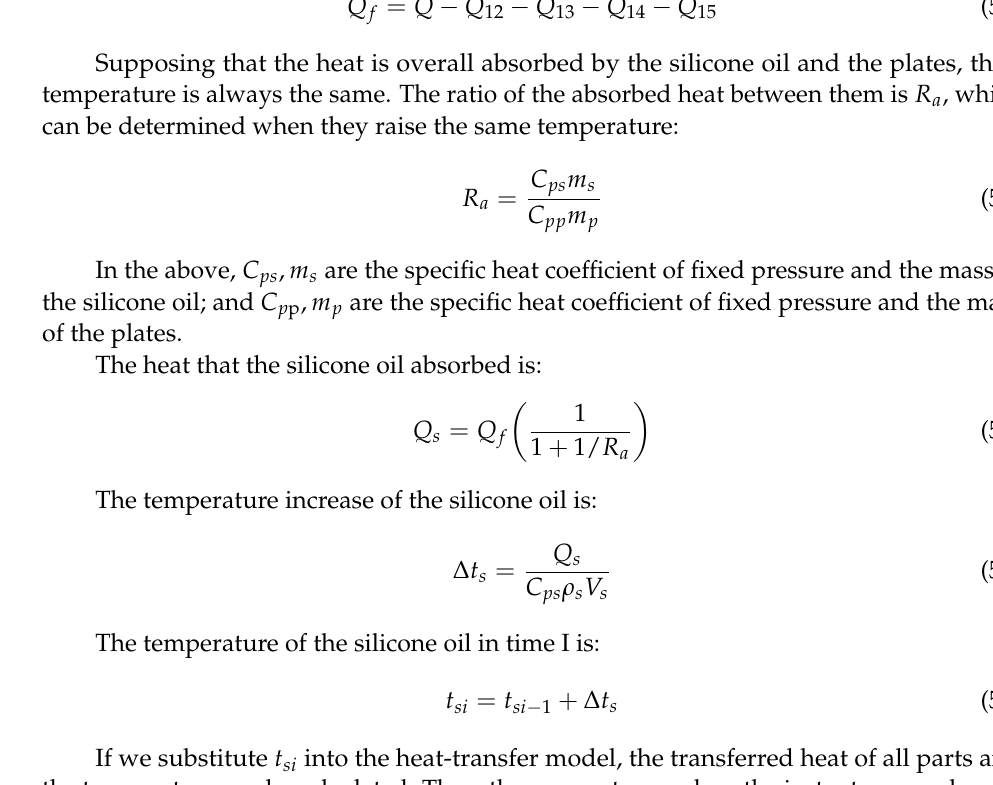
Figure 5. The limited slip torque of the VC. 4. Theoretical Analysis and Calculation of the Hump Mode of the VC When the VC operates at a large speed difference for a long time, the dissipation of the generated heat is insufficient. The excess heat will increase the temperature, inflate the volume, and increase the pressure, and the delivered torque will increase sharply. This is the hump phenomenon. There are several explanations for formation mechanism of the hump phenomenon in reference [7]. No final conclusion has been reached on it so far, but the theory in reference [14] is well accepted. When the hump phenomenon occurs, the internal pressure is very high and difficult to measure. This necessitates the theoretical evaluation. Based on the generation mecha- nism of the hump phenomenon, the following assumptions are made to evaluate the in- ternal pressure: (a) The solubility of silicone oil to air is very low. The proportion of air is considered to be quite small (ignorable) inside the silicone oil; (b) When the hump phenomenon occurs, the gas inside the VC is considered to be an ideal gas, and thus follows the physical law of ideal gases; (c) During the hump phenomenon, the pressure of gas inside the VC is the same as that of the other parts. Based on the above assumptions, the combined gas law is applied to calculate the internal air pressure, which will be used as the pressure inside the shell of the VC. From the combined gas law: